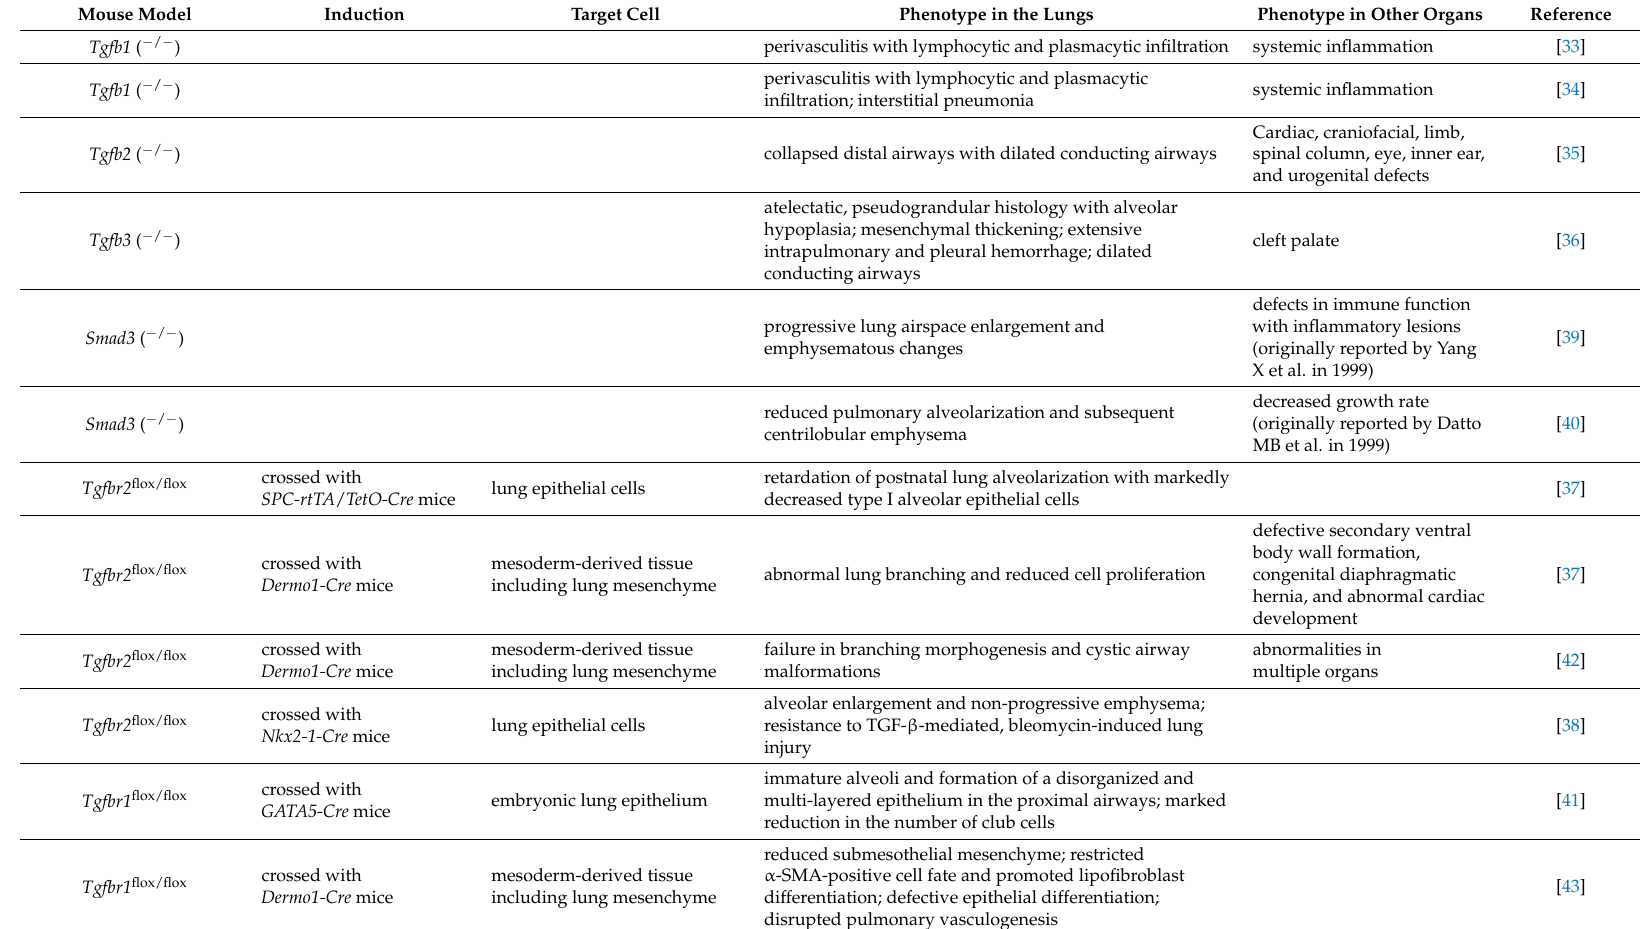
Table 1. Genetically engineered mouse models that demonstrate the roles of TGF- β signaling in lung